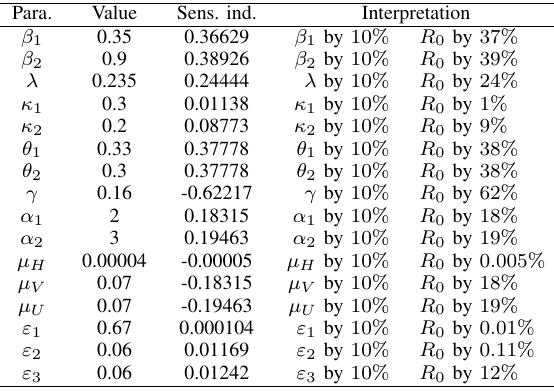
Fig. 3: Signs of the sensitivity indices of the movement rates κ 1 and κ 2 in terms of the biting rates β 1 and β 2 . Table II: Sensitivity indices and their